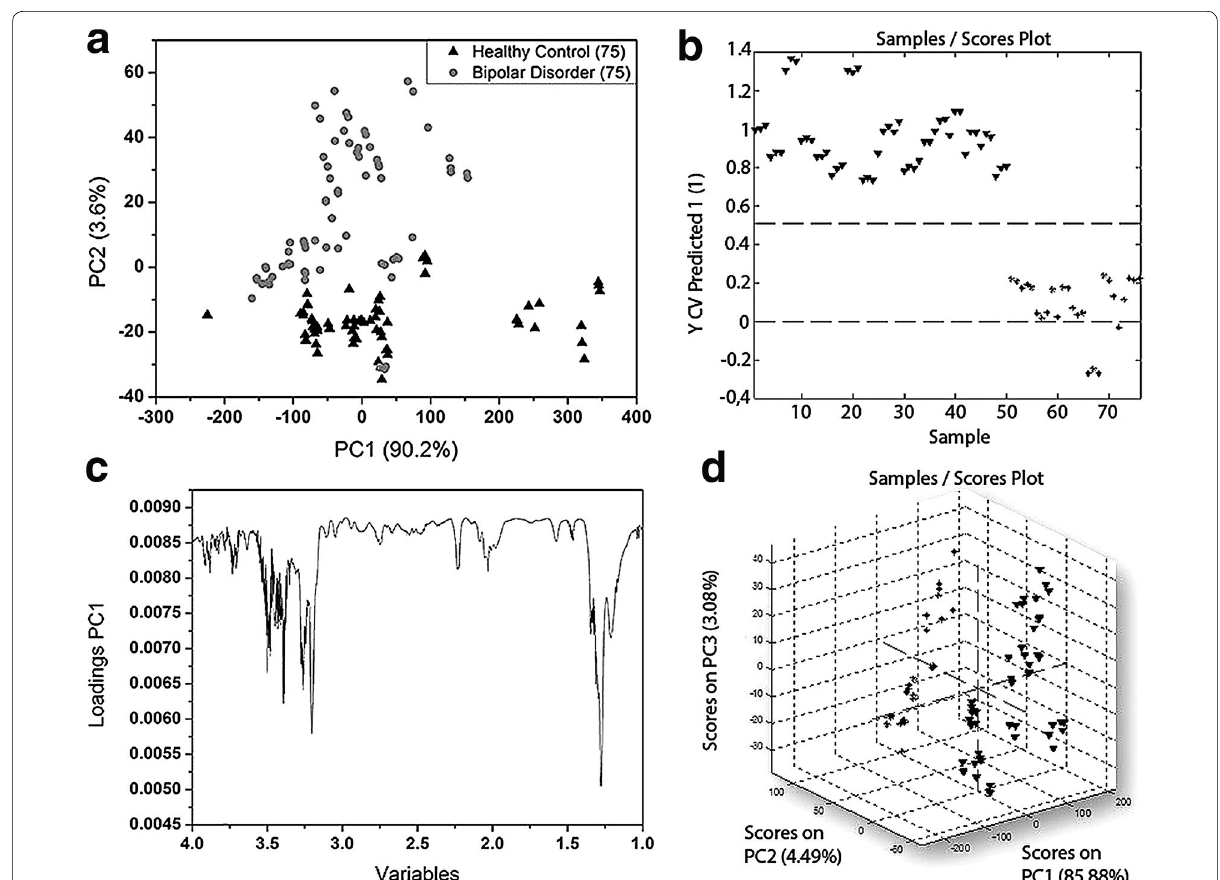
Fig. 2 Metabolomics discriminate bipolar disorder patients from healthy individuals. a Plots of cross‑validated PCA scores, 50 samples (25 BD HC) is equivalent to 150 spectra (75 BD 75 HC). b 2D samples scores plot of PLS‑DA, 76 samples (26 BD + BD 150 HC). c Loadings Graph of spectral region δ 1.00 to 4.40 used in chemometrics. d 3D samples scores plot of +